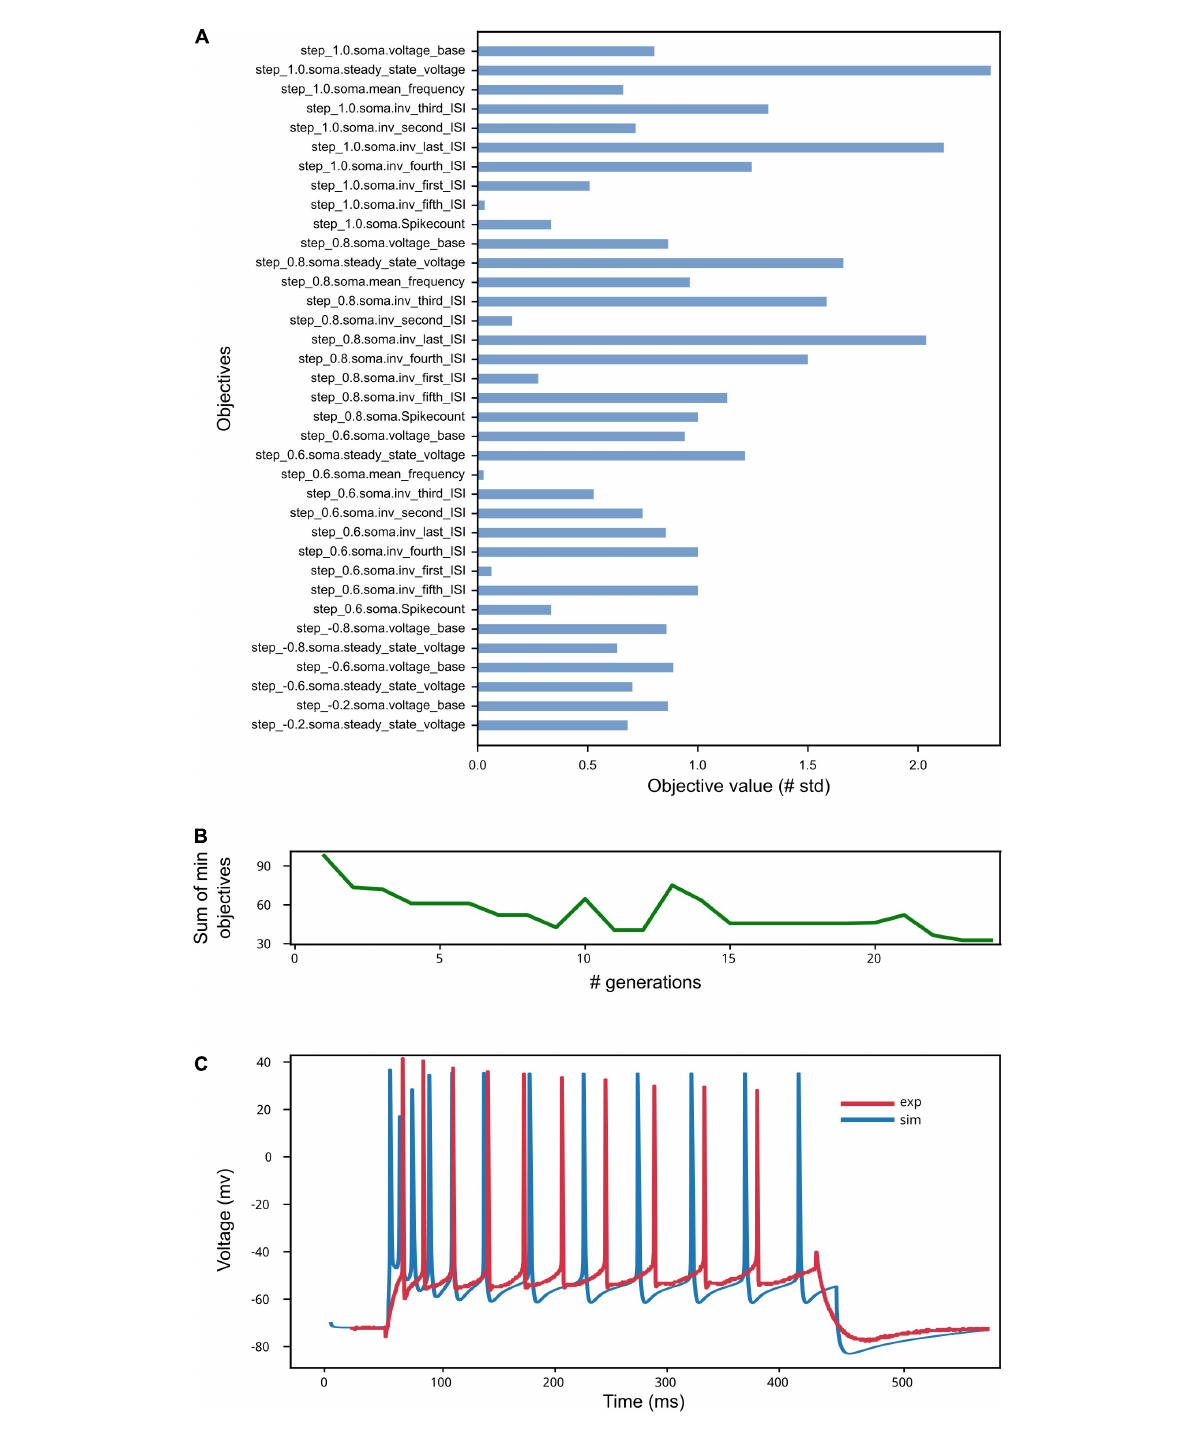
FIGURE9 Model Optimization results. (A) The objective scores convey information on the deviation of the electrophysiological features computed on the simulated activity from the same features values extracted from in vitro experiments and used in the optimization process (see Van Geit et al., 2016). Close-to-zero values have not been reported for ease of visualization. (B) The sum of the smallest objectives tends to decrease as the number of generations adopted for the genetic algorithm execution increases. (C) Example of simulated model activity recorded at soma location for a 1 nA step stimulus amplitude, plotted against one of the experimental traces selected for the extraction of the features used for the model optimization. The spike count and the spike timing are comparable as well as the voltage base value. Given that the experimental behavior that the model aims to capture is obtained against the average feature values extracted from multiple recordings, individual simulated and experimental traces will present variable differences, depending on the extent of success of the optimization